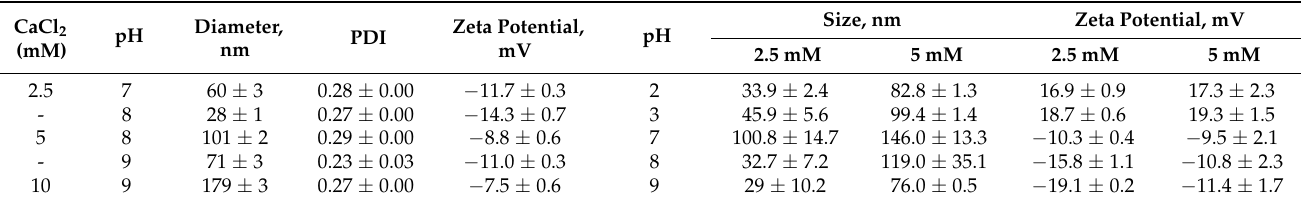
Table 7. Influence of various parameters on the size and zeta potential of soy protein nanoparticles. Reprinted with permission from ref. [111]. Copyright 2012